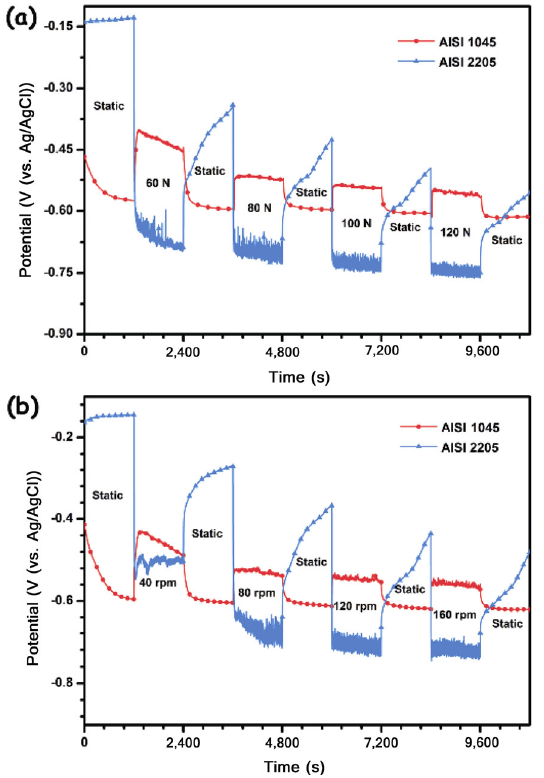
Fig. 6 Evolution of the OCP as a function of time during intermittent sliding under varied (a) load and (b) speed.